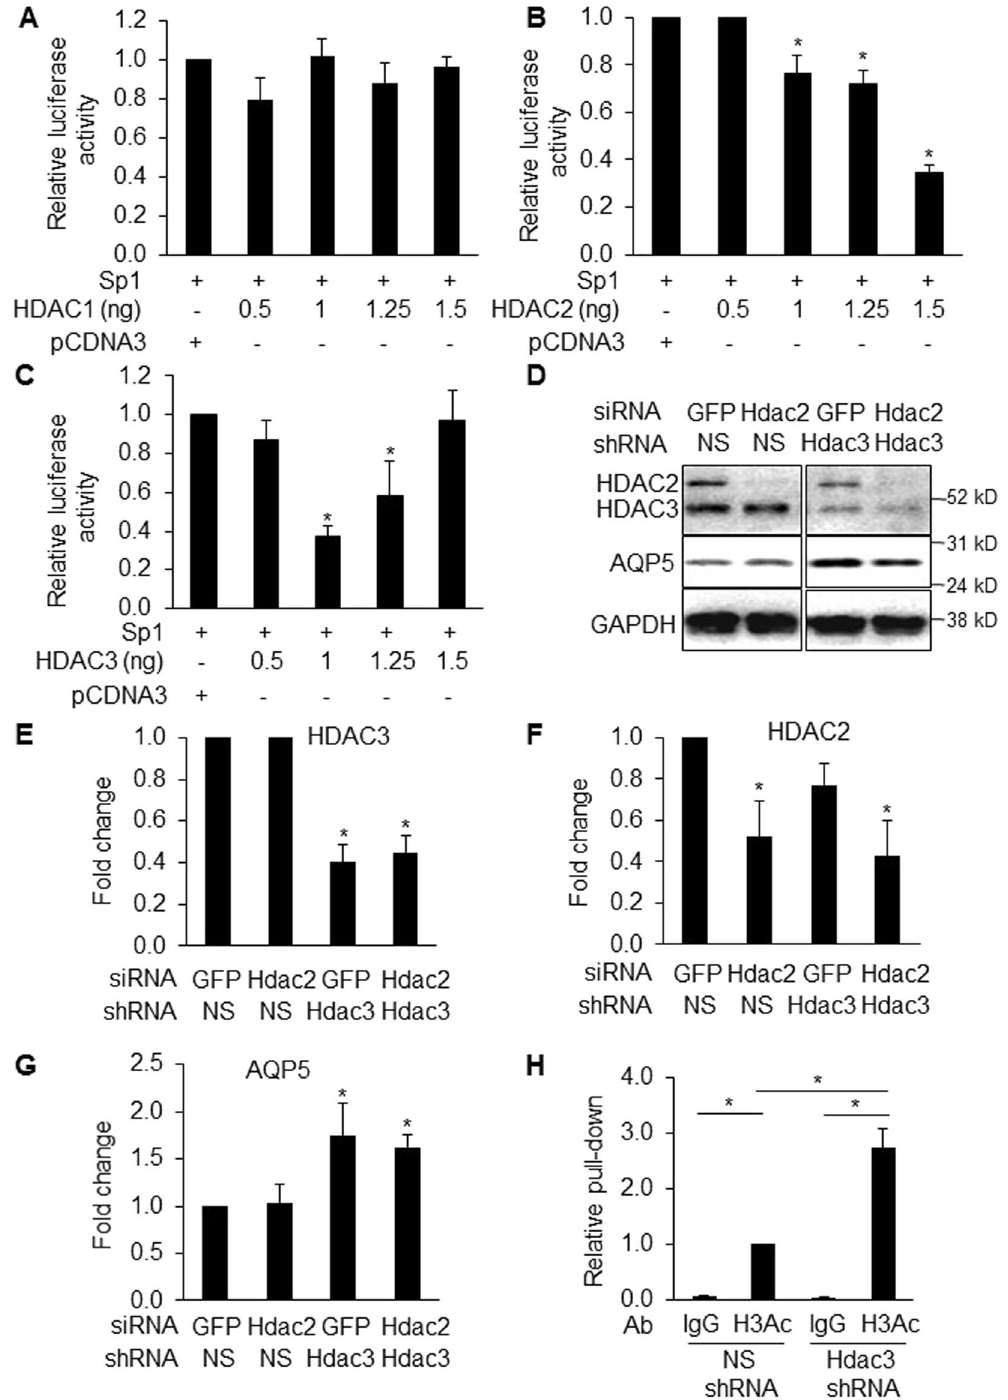
Figure 2. HDAC3 modulates expression of AQP5. NIH3T3 cells were co-transfected with 358- Aqp5 -Luc, Sp1 and increasing amounts of HDAC1 ( A ), HDAC2 ( B ) and HDAC3 ( C ) expression vectors or empty vector (pCDNA3). HDAC2 and HDAC3, but not HDAC1 inhibited Sp1-activated Aqp5 transcription. Protein concentrations were used for sample normalization (n = 3, * p < 0.05 compared to empty vector). WB ( D ) and corresponding quantitative analysis ( E – G ) show that AQP5 expression (normalized to GAPDH (37 kD)) is significantly upregulated ( D , G ) following knockdown of HDAC3 (59 kD) with shRNA ( D , E ) but not HDAC2 (49 kD) with siRNA ( D , F ) (n = 3, * p < 0.05 compared to non-silencing shRNA and GFP siRNA) in MLE-15 cells. ( H ) ChIP with anti-acetyl-H3 Ab (H3Ac) demonstrates enrichment of H3 acetylation at the Aqp5 promoter/enhancer region homologous to the proximal 358-bp of the rat Aqp5 promoter following HDAC3 knockdown in MLE-15 cells (n = 3, * p < 0.05). ChIP efficiency was calculated relative to non-silencing shRNA (NS-shRNA)-treated cells precipitated with H3Ac Ab, which was set as 1. Rabbit IgG pull-down is used as